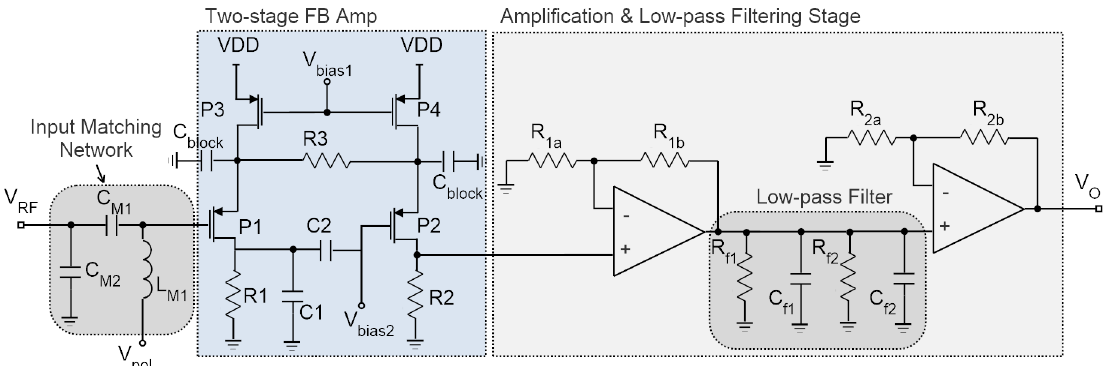
Figure 4. RFED WuR with a feedback amplifier stage [7].